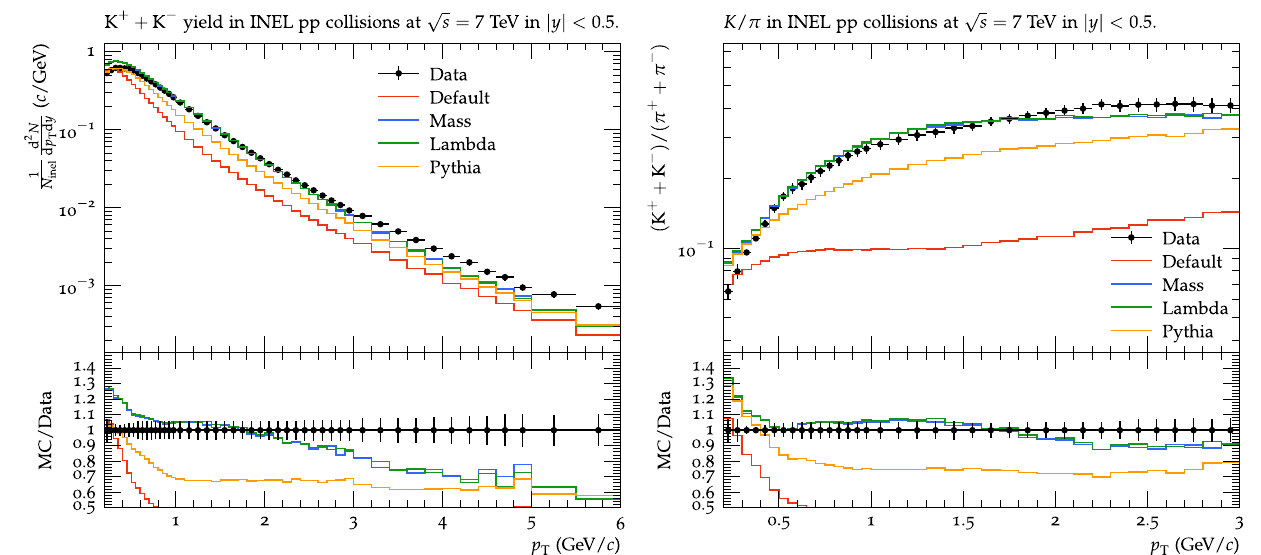
Fig. 10 K + + K − yield and K /π ratio as measured by ALICE [25] at 7 TeV. Shown is a comparison between the default version of Herwig (without baryonic reconnection), i.e. static production of strangeness,